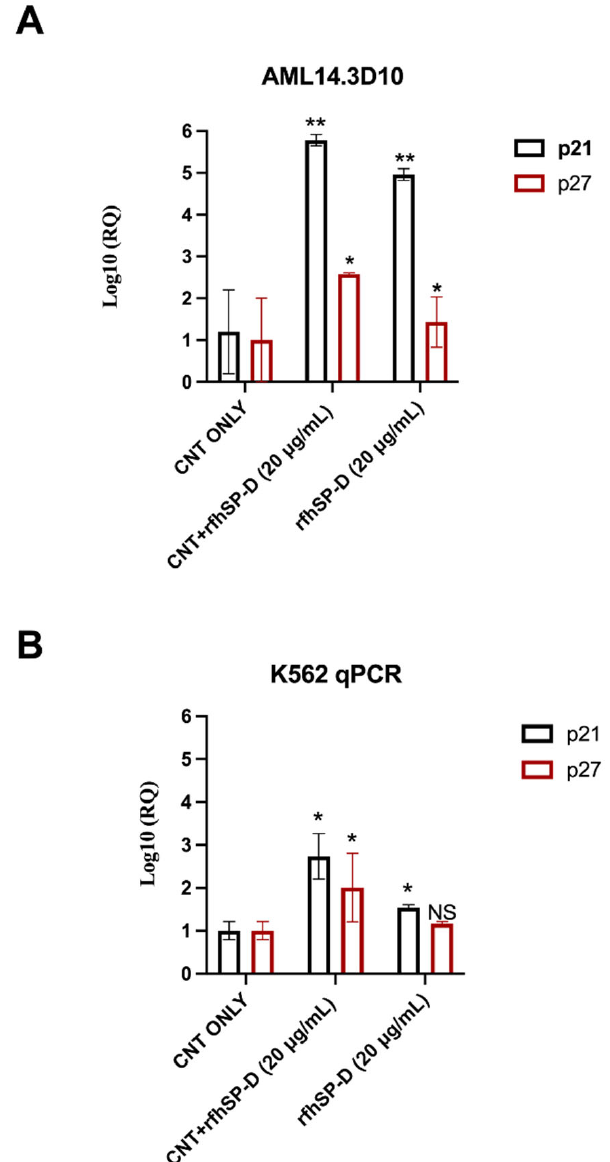
Figure 6. CNT + rfhSP-D treatment causes the upregulation of p21 and p27 cell cycle inhibitors in AML14.3D10 ( A ) and K562 ( B ) cell lines. AML14.3D10 or K562 (0.4 × 10 6 ) cells, treated with CNT + rfhSP-D (20 µ g/mL) or rfhSP-D (20 µ g/mL), plus untreated control (cells+ CNT) (20 µ g/mL), were used for RNA extraction, cDNA synthesis and RT-qPCR, using 18S as an endogenous control. The RQ value was calculated using the formula: RQ = 2 − ∆∆ Ct. Values represent means ± SEM ( n = 3). * p < 0.05 and ** p < 0.01 compared to CNT only group.